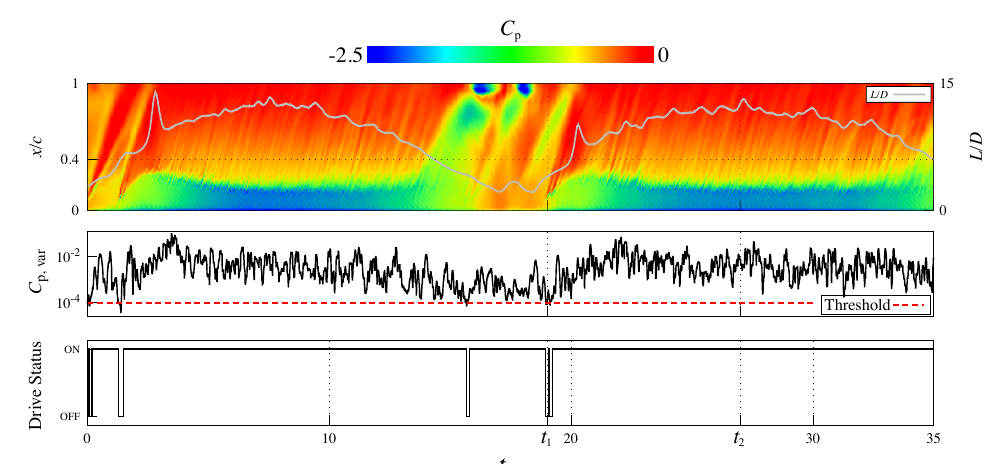
Figure 10. Time histories of L / D , C p,var at the pressure sensor and the drive status of the plasma actuator in FTM1 from top to bottom. The top figure overlaps with the distribution of the spanwise- averaged C p on the upper surface of the airfoil in the x / c - t